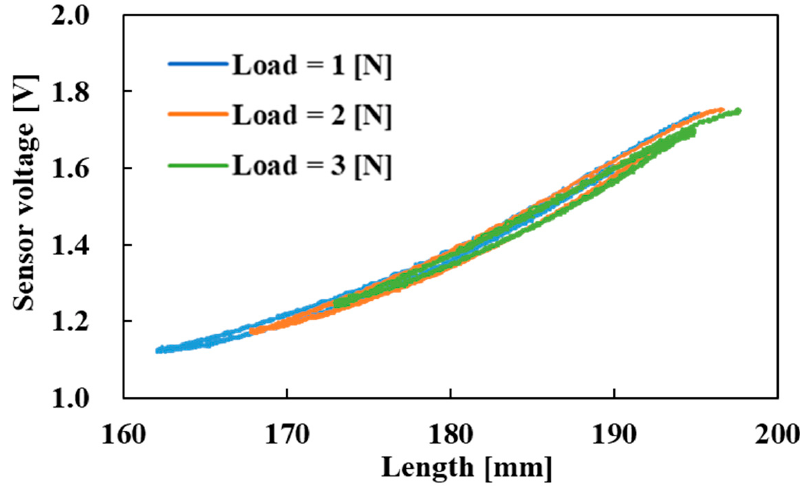
Figure 18. Change in sensor voltage due to load.